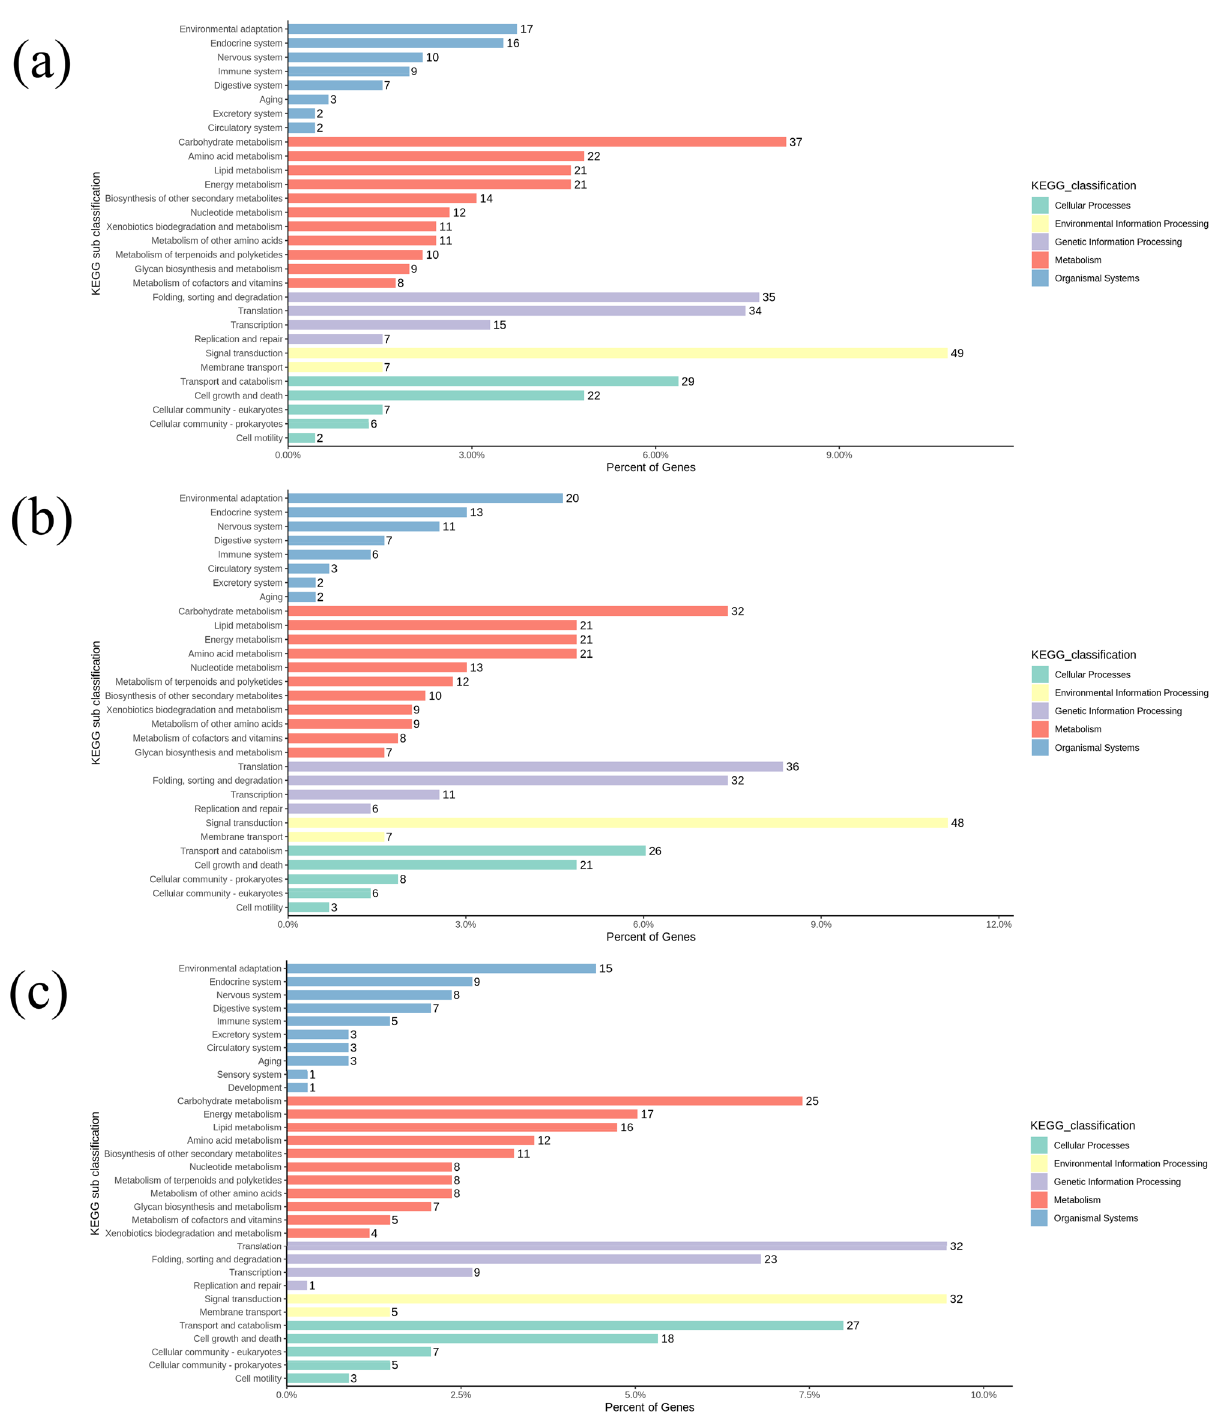
Figure 6. Functional annotation analysis of DEGs was carried out through KEGG metabolic pathway analysis. ( a ) Enriched KEGG metabolic pathways in 7 DPA fiber vs. nonfiber tissues; ( b ) enriched KEGG metabolic pathways in 14 DPA fiber vs. nonfiber tissues; ( c ) enriched KEGG metabolic pathways in 26 DPA fiber vs. nonfiber